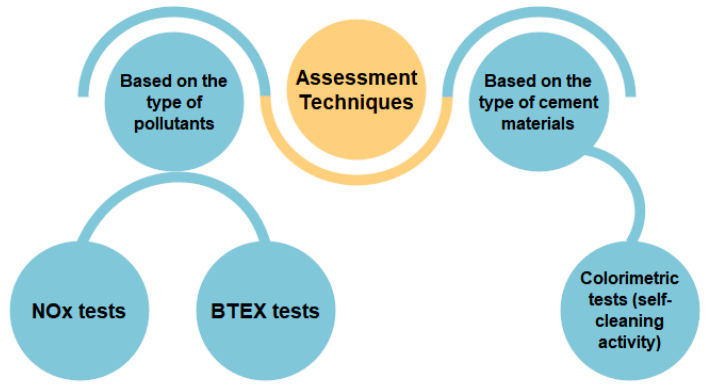
Figure 18. Test methods to evaluate the efficiency of photocatalytic activity in cementitious materials as reported in the literature. BTEX — benzene, toluene, ethylbenzene, and xylene.